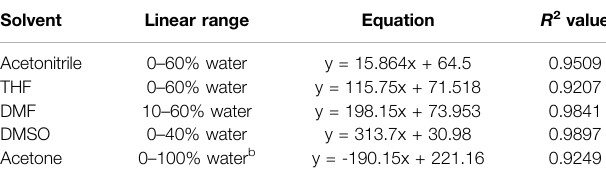
TABLE 2 | The linear relationship between the percentage of water added to solutions of bimane 1 in water-miscible solvents and the quantitative blue value of the resulting solution when imaged under 365 nm excitation. a